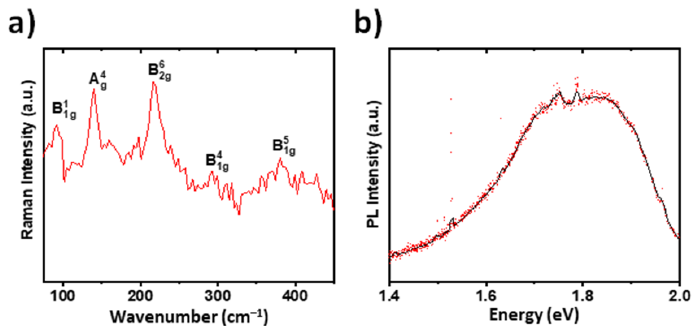
Figure 3. ( a ) Raman and ( b ) PL spectra of the BaZrS 3 film measured at 300 K. The sharp spikes from the PL spectra come from the sapphire substrate. The black line shows the smoothed curve derived from the average of the experimental results.